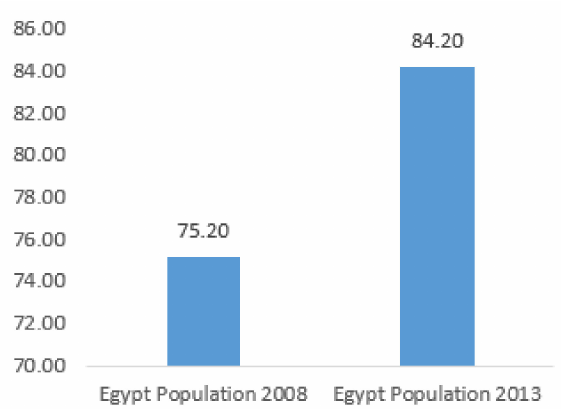
Figure 1. Egypt’s population (millions), adapted from